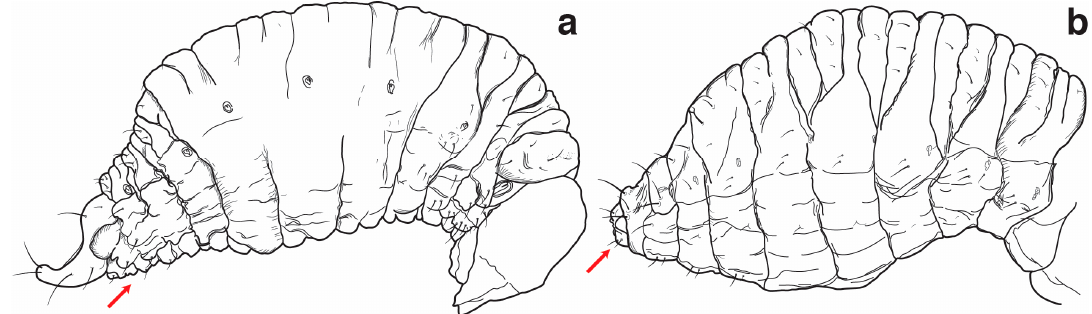
Figure 5. Thorax and abdomen, larva, lateral view: ( a ) Phacecorynes zamiae ; and ( b ) Eugnoristus braueri .